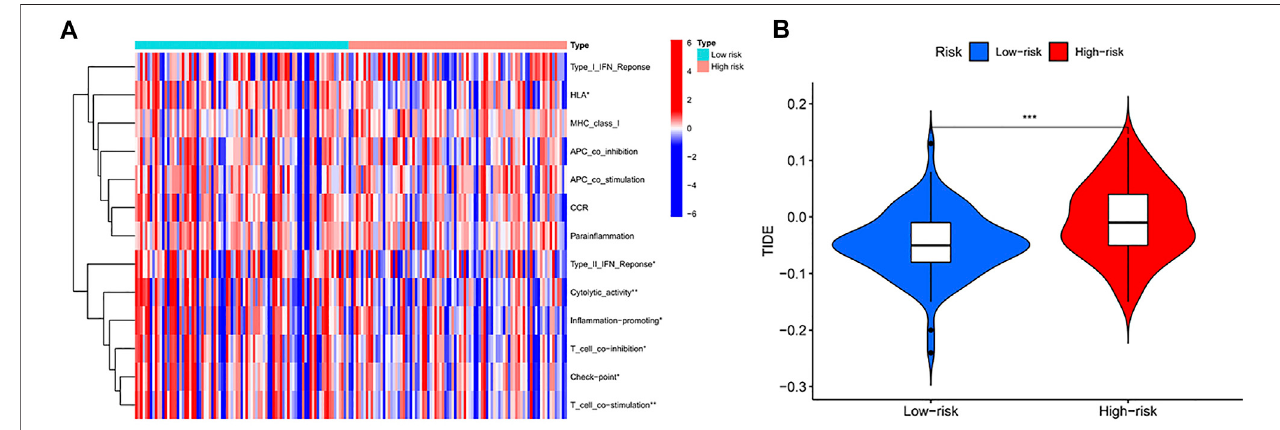
FIGURE 7 | The sensitivity (IC50) of ABT.888, ATRA, AP.24534, AG.014699, ABT.263, axitinib, A.443654, and A.770041 between high and low risk groups.